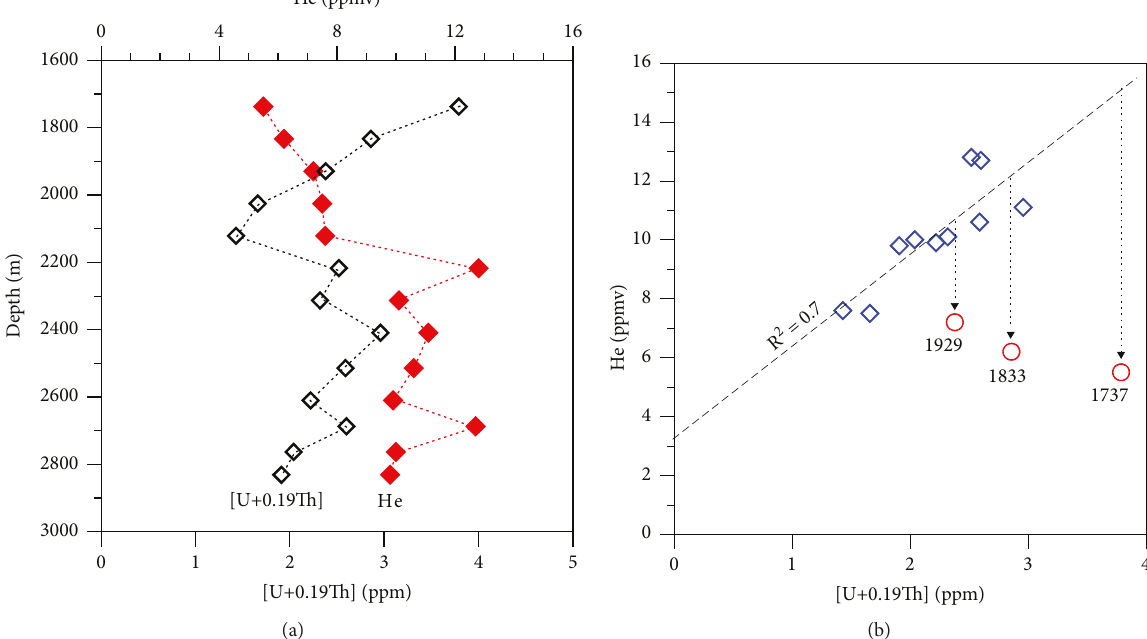
Figure 8: (a) Plot showing depth distribution of [U+0.19Th] (black open diamonds) and He (red diamonds). [U+0.19Th] values are averaged over the same ~ 100m depth intervals as the depth of the water columns from where helium was extracted. (b) Correlation diagram for He versus [U+0.19Th]. Blue open diamonds indicate data from below 2100 m depth, where a positive correlation ( R 2 = 0 70 ) is obvious. Red open circles are data from shallower depth which might be a ff ected by helium loss